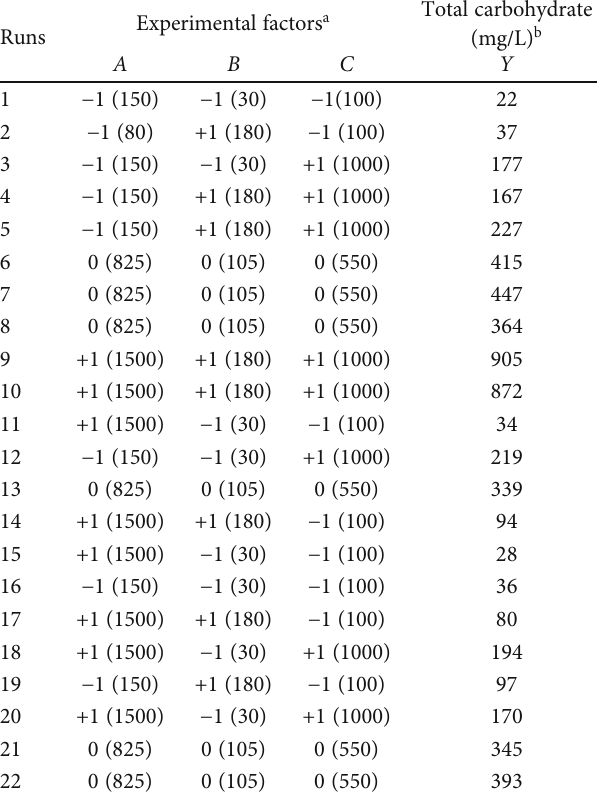
Table 2: Design matrix of two-level FFD with total carbohydrate ( Y ) as response.